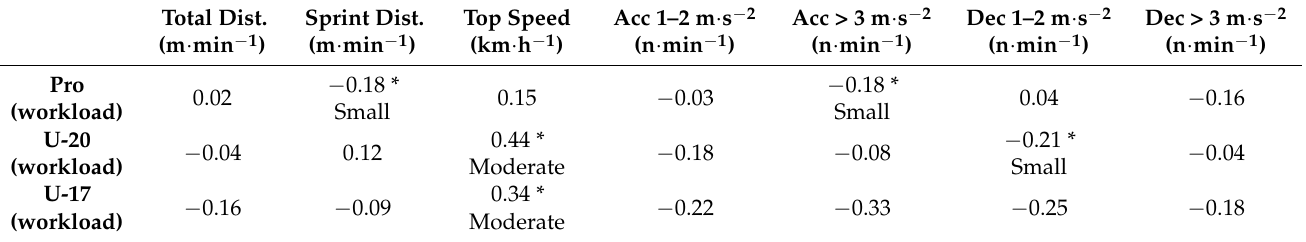
Table 2. Correlations among workload and all GPS